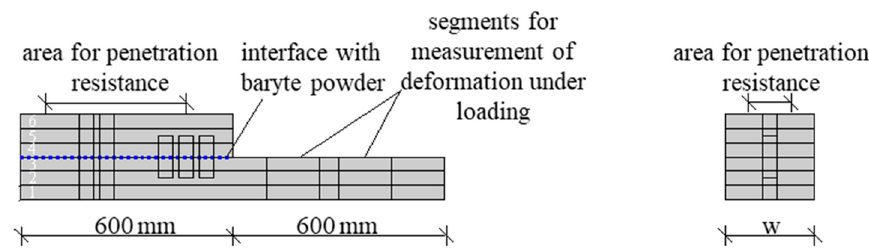
Figure 3. Principle of sampling: production of three long layers and subsequently three short layers. The series of investigation are named as indicated in Table 1. Every experiment reveals the accelerator dosage in percent and-if relevant-the interlayer time ∆ t in between layer three and four in minutes. Each experiment is repeated twice.